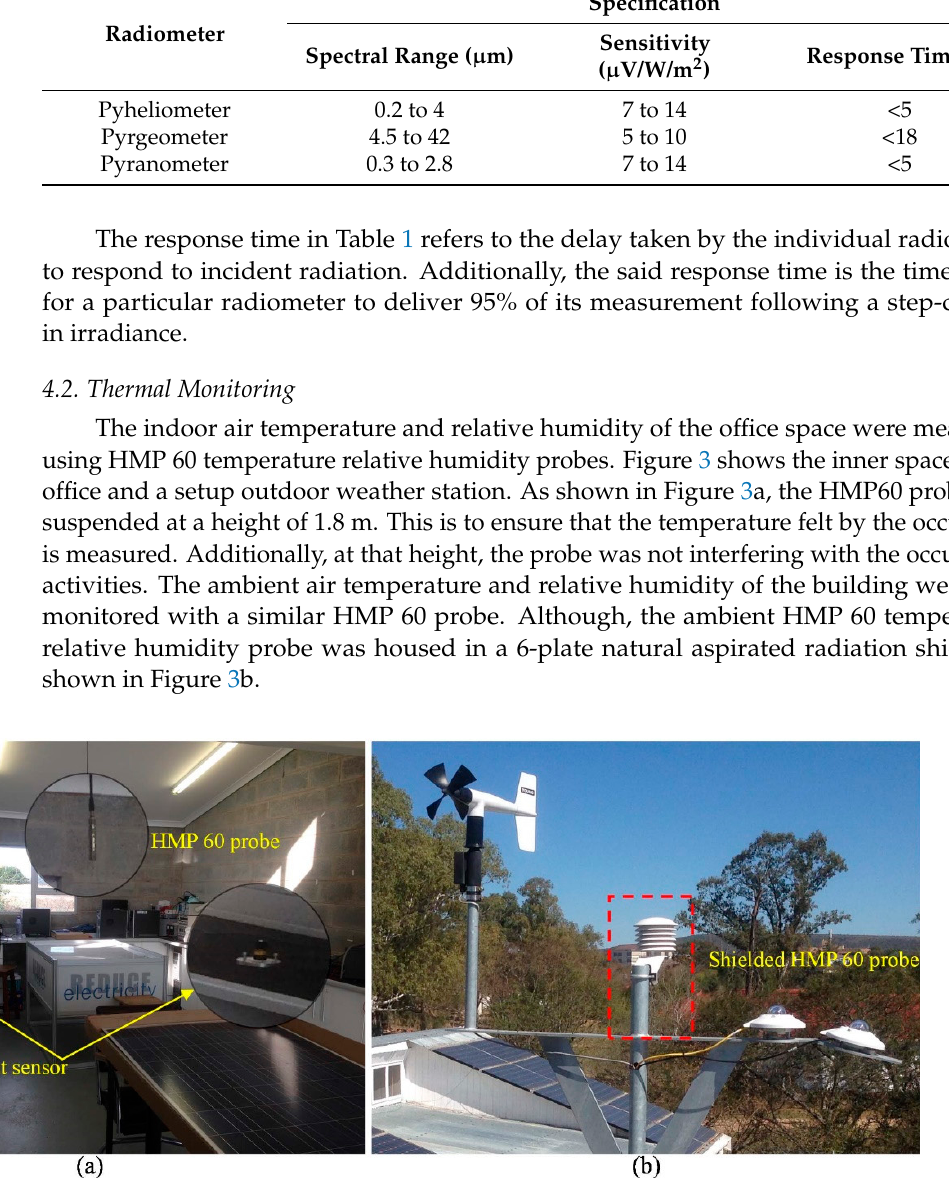
Table 1. Specification of the radiometers.